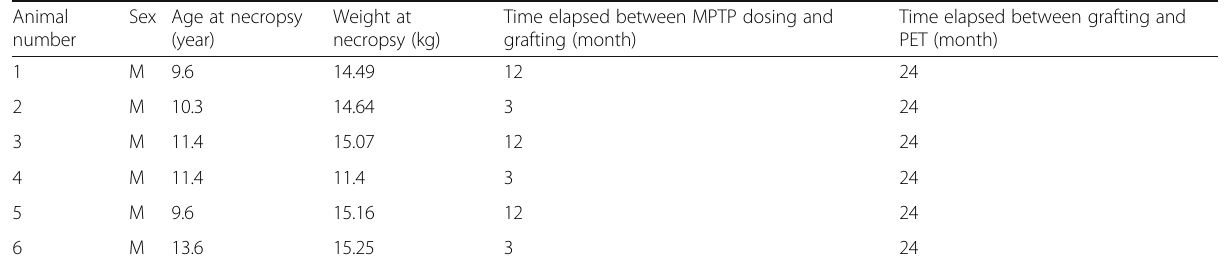
Table 1 Information regarding rhesus macaques ( Macaca mulatta ) used in the study Animal Sex Age at necropsy number